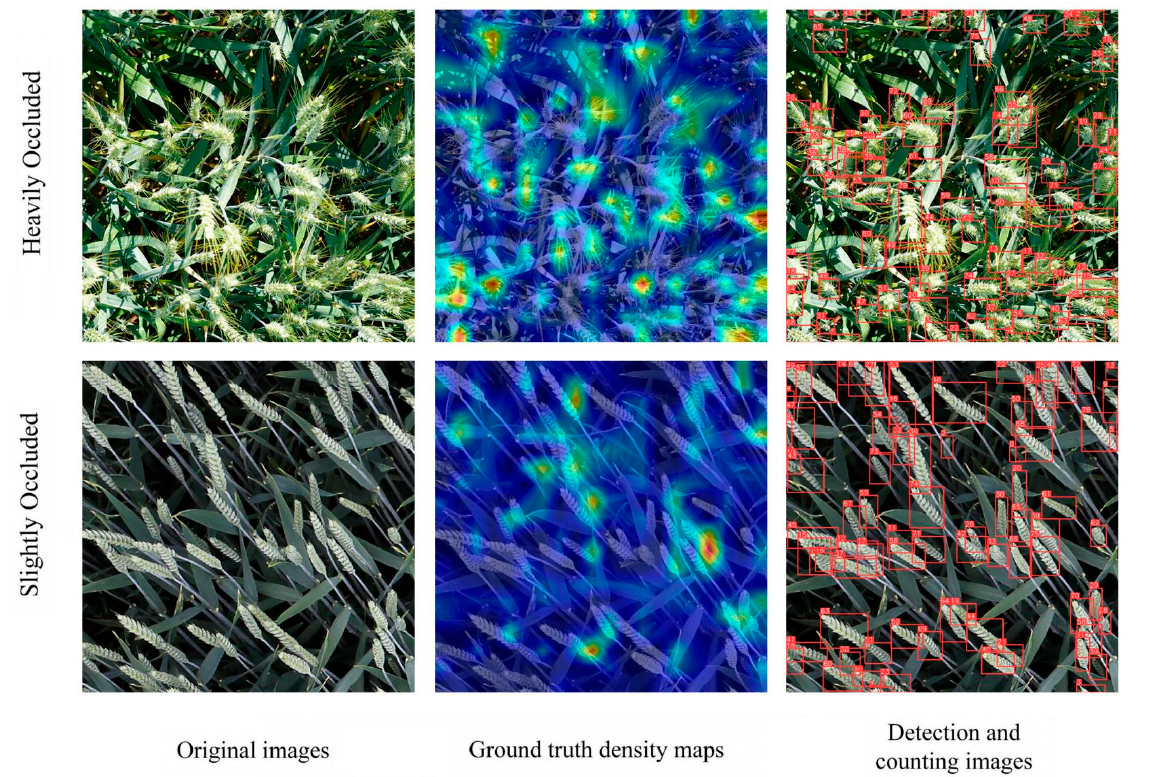
Figure 16. Comparison of the detection results of wheat ears with different degrees of occlusion.